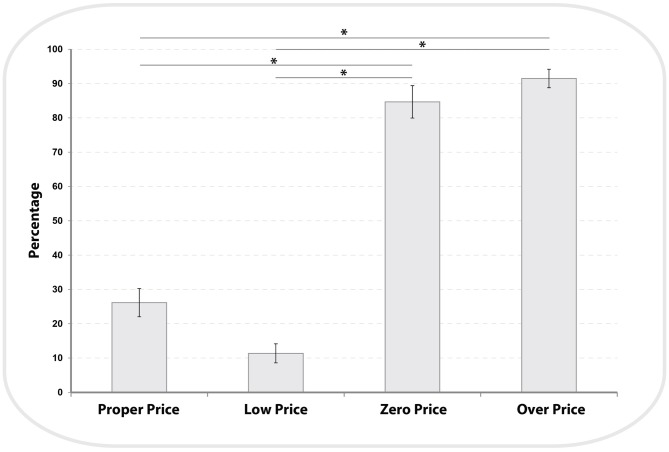
Distribution of demand for Low Price (LP) items across all four pricing binary choices. The demand for LP items during Zero and Over conditions was significantly higher (see*) compared to Proper and Low price conditions (see “Results” Section).